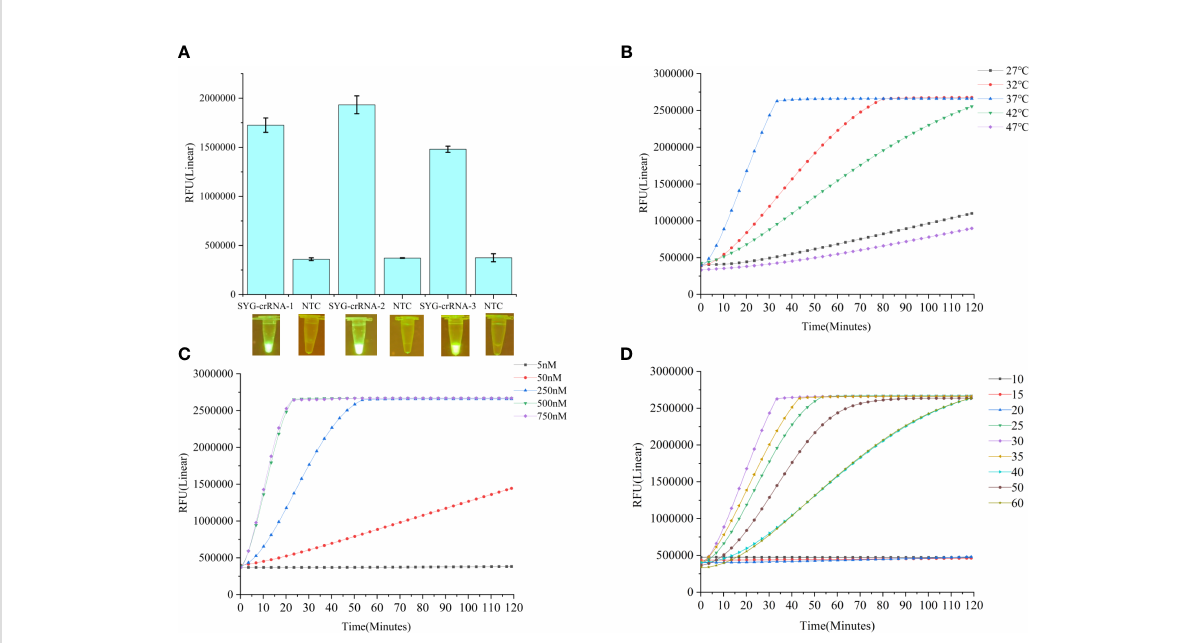
FIGURE 2 (A) Fluorescence changes of three crRNA reactions for 1 h detected by CRISPR-Cas12a fl uorescence assays. Values are shown in the graph as means ± SD (n = 3). (B) Fluorescence curves at different reaction temperatures. (C) Fluorescence curves of different crRNA concentrations. (D) Effects of different LAMP reaction times on the Cas12a reaction. NTC: no template